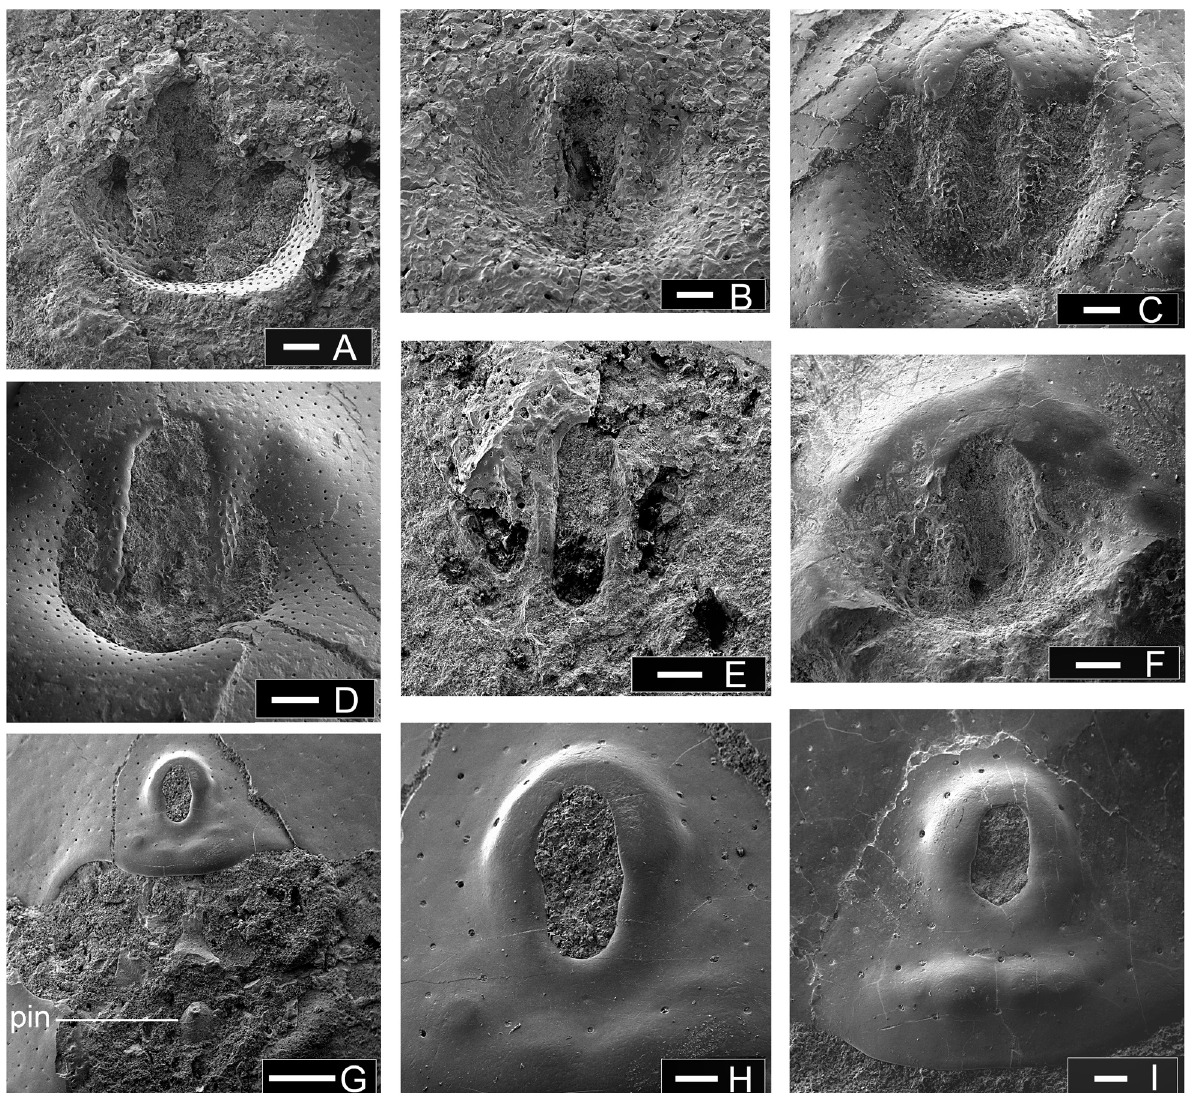
Fig. 9. Nasohypophyseal region of the species of Tremataspis . A – C , T. schmidti Rohon; D , T. milleri Patten; E , T. rohoni Robertson; F – I , T. mammillata Patten. Locations : A, GIT 846-9, Elda Cliff, bed II; B, GIT 846-4, Viita Quarry; C, 846-11, Elda Cliff, loose material; D, GIT 846-7; E, GIT 846-10, Elda Cliff, bed IV; F, TUG 1030-27; G= H, TUG 1025-586; I, TUG 1025-803, Himmiste Quarry; Himmiste Beds of Paadla Regional Stage, Gorstian, Lower Ludlow. Scale bar = 200 µm (A–F, H, I), 1 mm (G). Abbreviations : pin, pineal